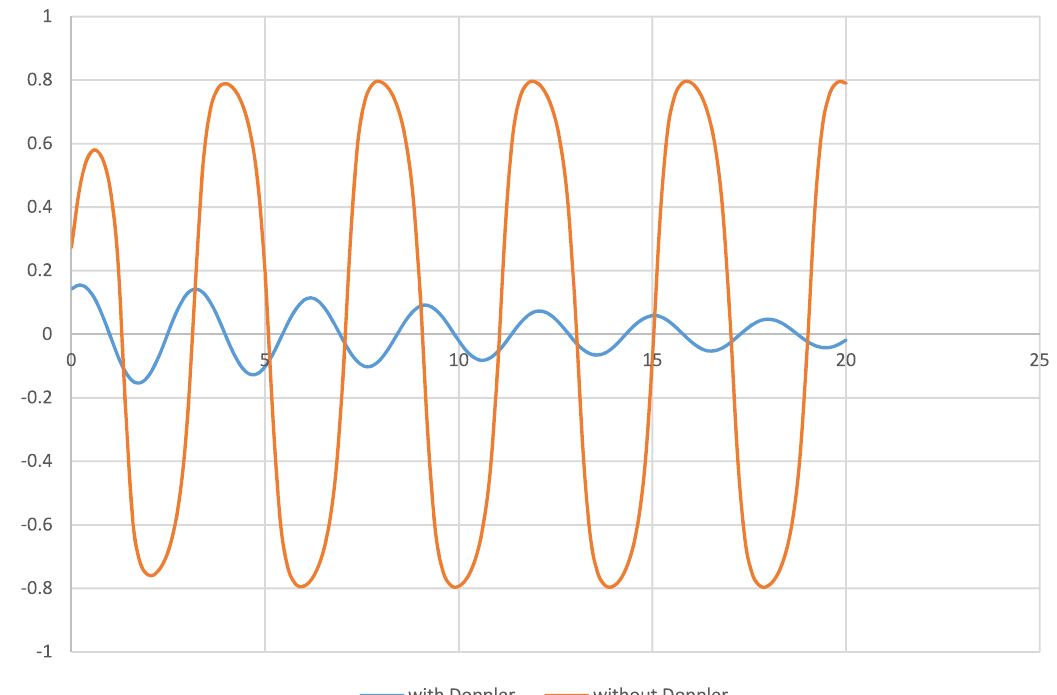
Fig. 7. Evolution of AO p with/without Doppler effect ( b = 0.01/3).